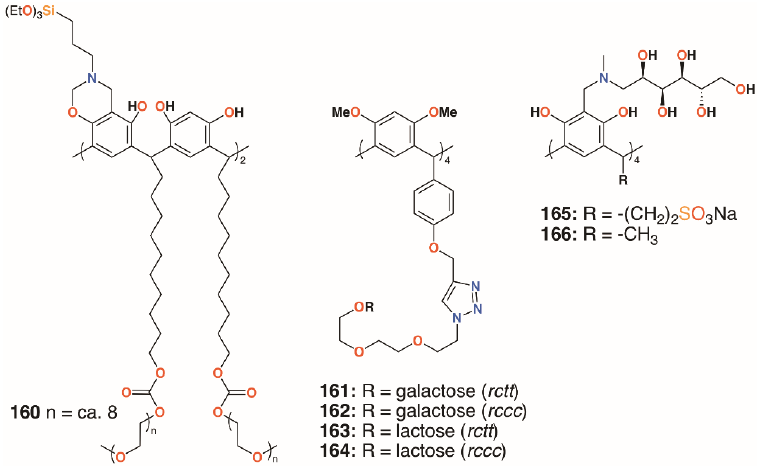
Figure 25. Resorcinarene derivatives of Guildford, Matthews, and Kashapov.